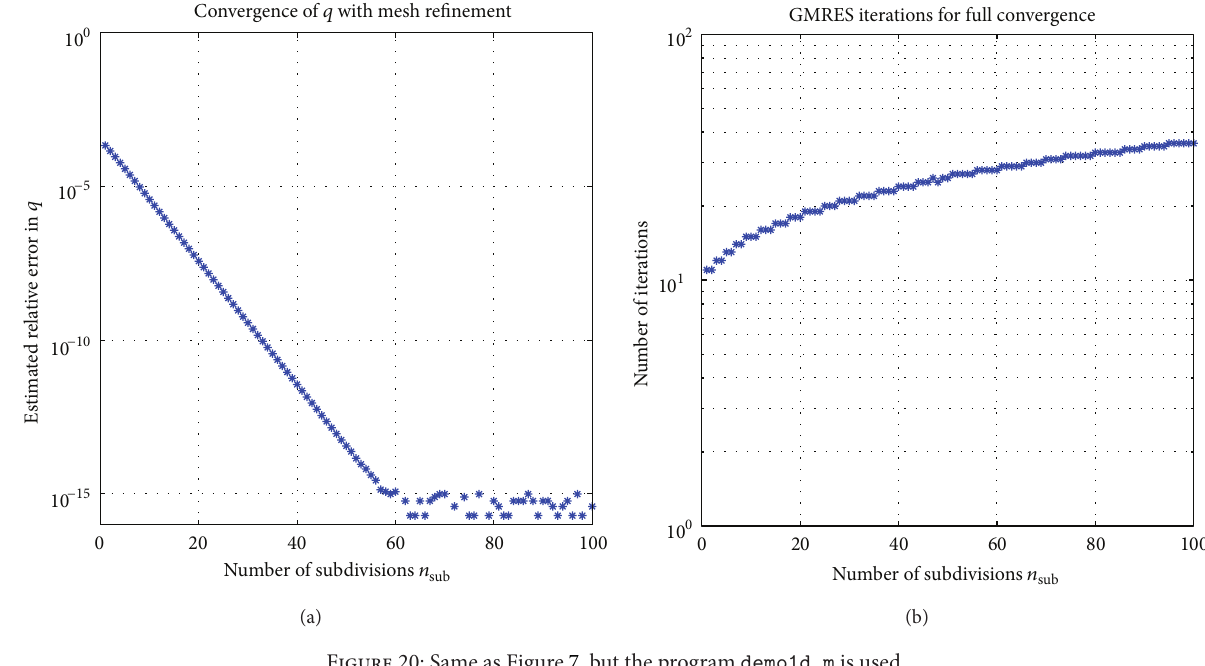
Figure 20: Same as Figure 7, but the program demo1d.m is